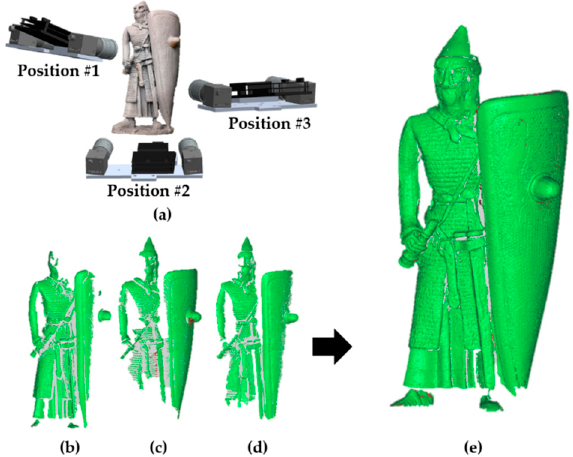
Figure 4. ( a ) 3D scanning configuration at various viewpoints; ( b ) 3D scan data from position #1; ( c ) 3D scan data from position #2; ( d ) 3D scan data from position #3; ( e ) Registration result of the 3D scan data ( b – d ).